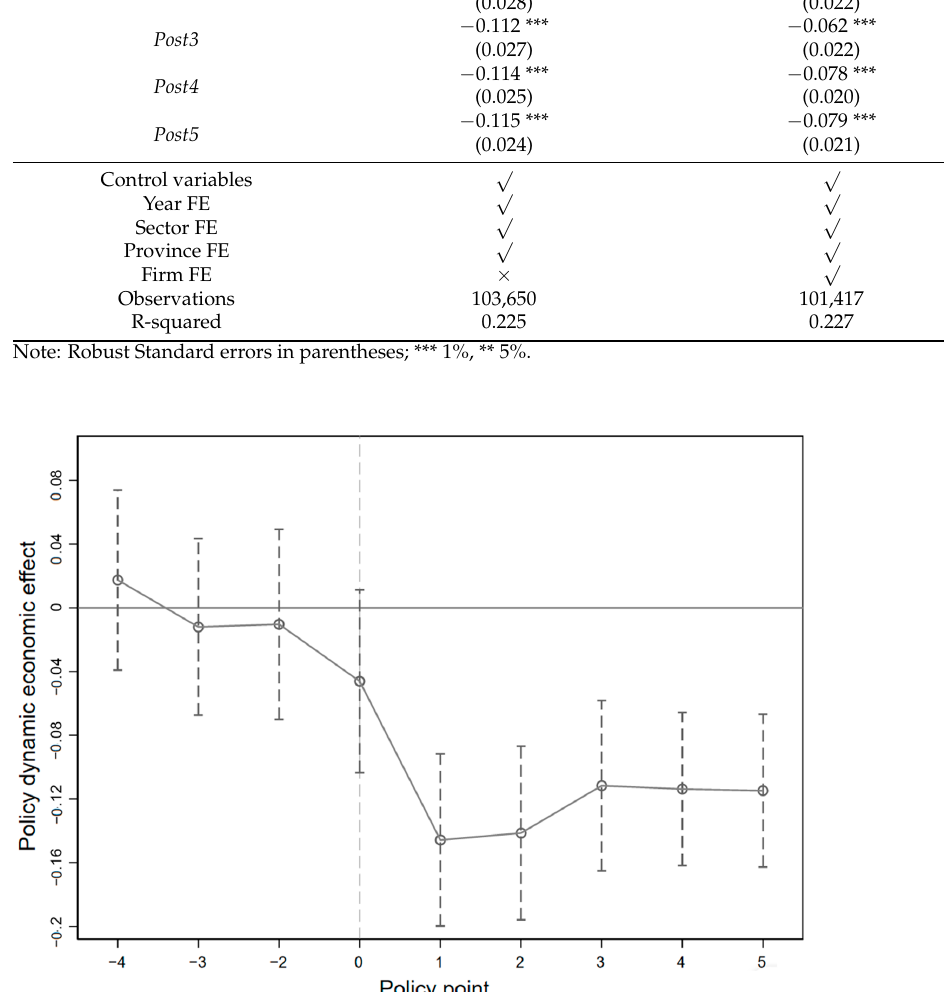
Figure 7. Parallel trend test and dynamic policy effect analysis of FE.